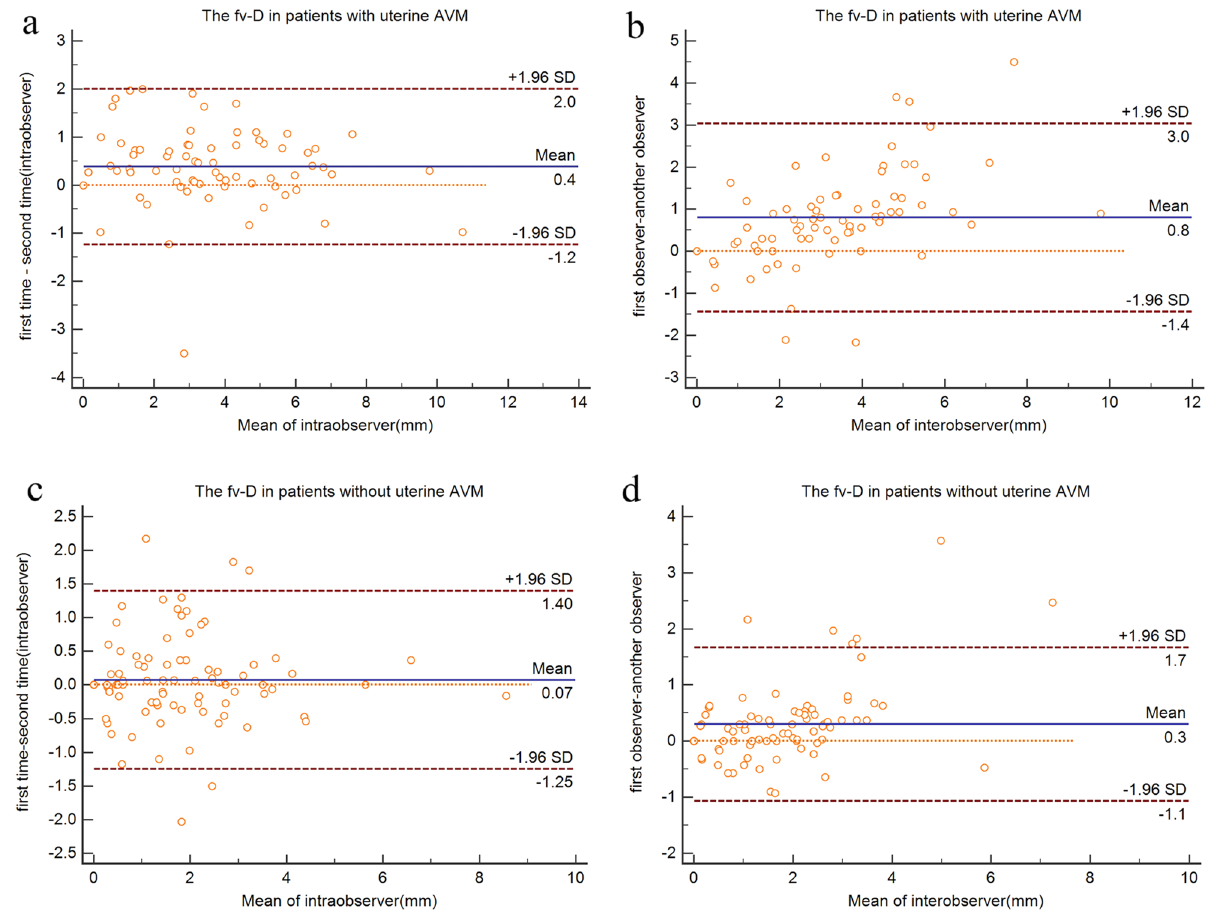
Figure 3. Bland–Altman plot showing agreement in the assessment of fv-D values on MRI. ( a , b ) The biases between intra- and interobserver measurements are 0.4 mm and 0.8 mm in patients with uterine AVMs; ( c , d ) The biases between intra- and interobserver measurements are 0.07 mm and 0.3 mm, respectively, in patients without uterine